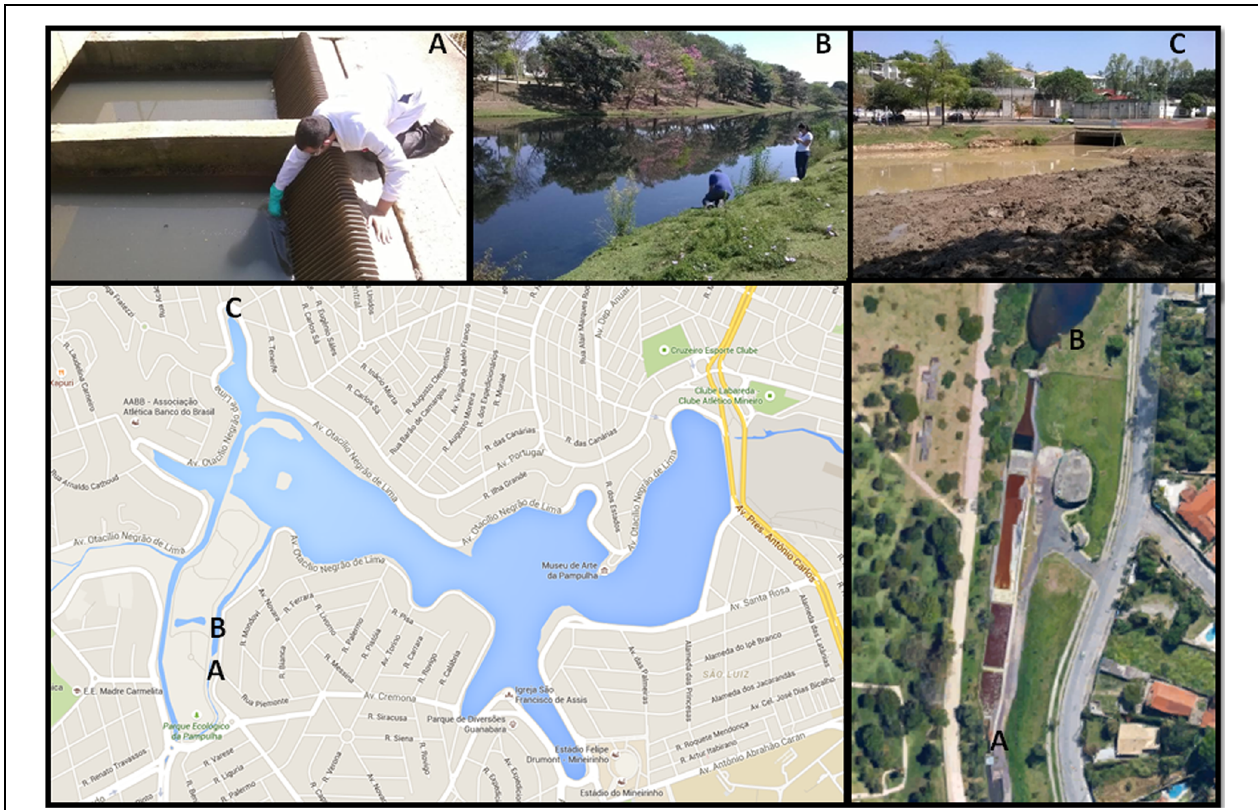
FIGURE 1 | Pictures from the three areas where the environmental samples were collected represented by letters (A–C). (A) Point 1, before the chemical treatment; (B) Point 2, after the chemical treatment; (C) Point 3, 3 is an isolated area of the lagoon (Google Earth).